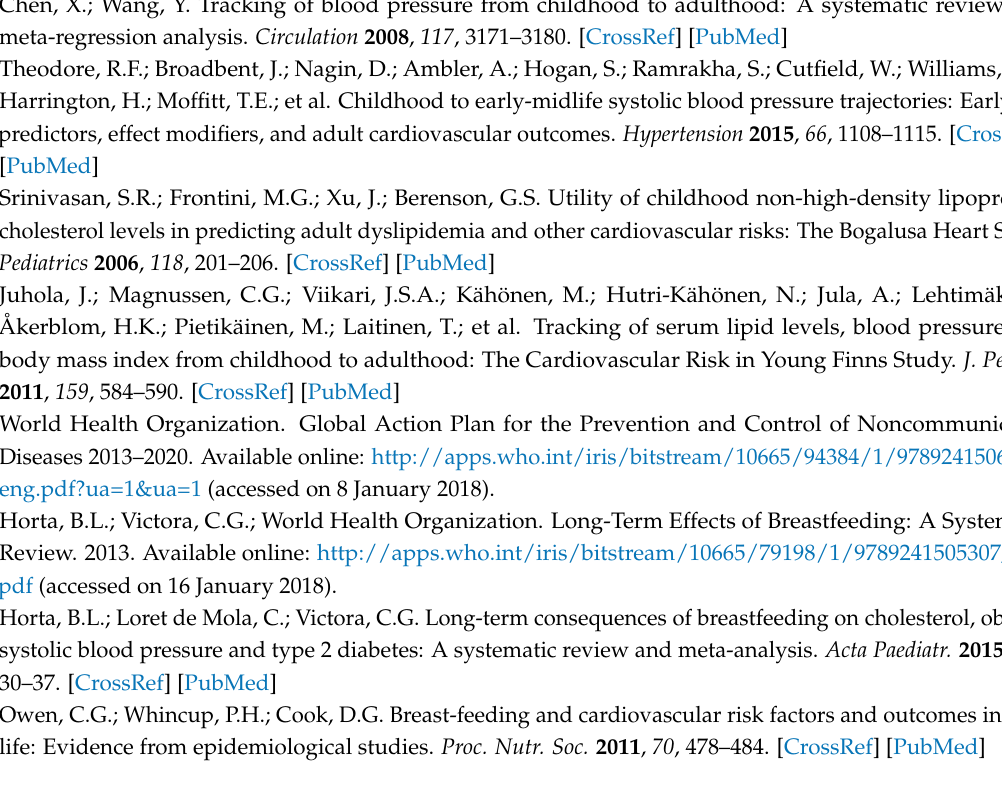
Table S1: Associations between breast milk DHA content and blood pressure and blood lipid profile, Table S2: Associations between breast milk EPA content and blood pressure and blood lipid